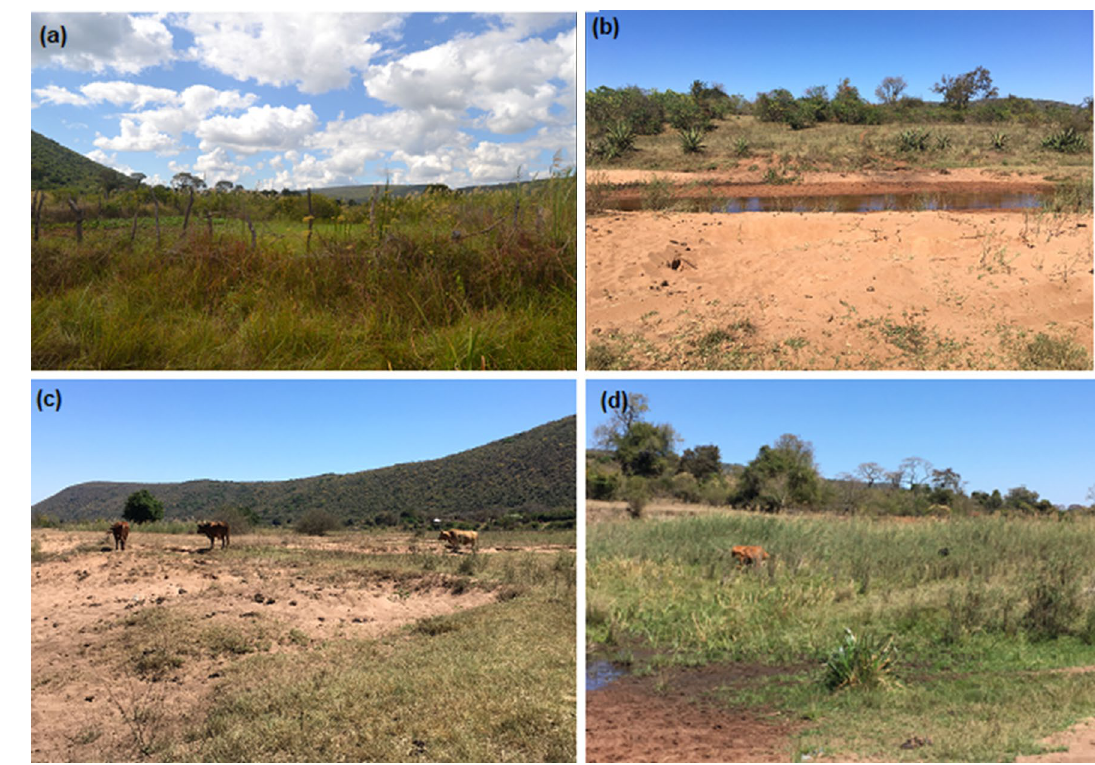
Fig. 6 Wetland degradation observed within the Sambandou wetlands: a wetland cultivation (site 2), b sand mining/poaching (site 4), c sand mining/poaching and cattle grazing causing erosion (site 1), and d cattle grazing (site